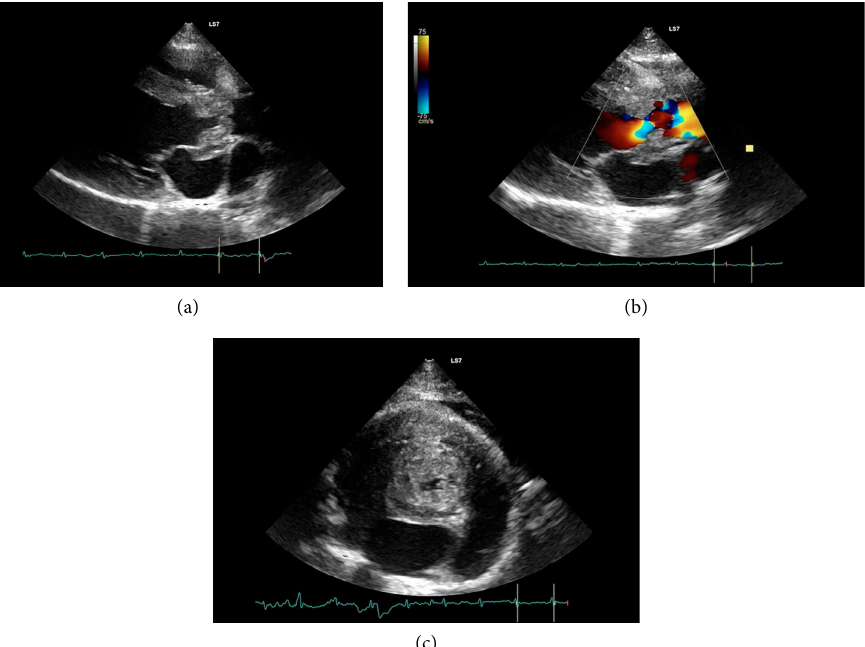
Figure 1: The right parasternal long axis view optimized for the left ventricular outflow tract, shows severe thickening of the aortic valves compatible with aortic bacterial endocarditis (a). In the right parasternal long axis view the aortic color doppler shows a significantly turbulent flow at the valvular cusps, suggestive of valvular aortic stenosis due to bacterial endocarditis (b). The right parasternal transverse (short axis) heart base view depicts, in the middle of the sector image, dramatic thickening of the aortic valve cusps (9.8 mm). The left atrium is below the aorta and it appears slightly compressed by the inflammatory process. On the upper right portion of the picture there is slight anechoic pleural fluid (c).